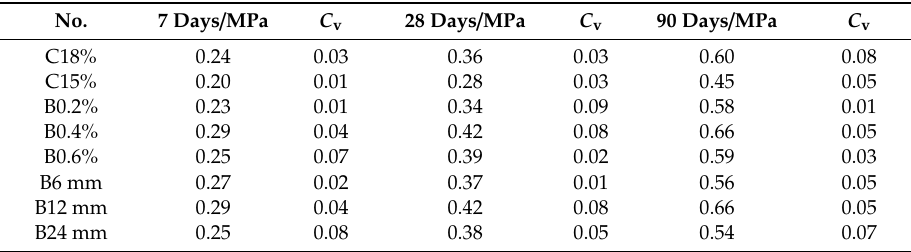
Table 4. Splitting tensile strength.